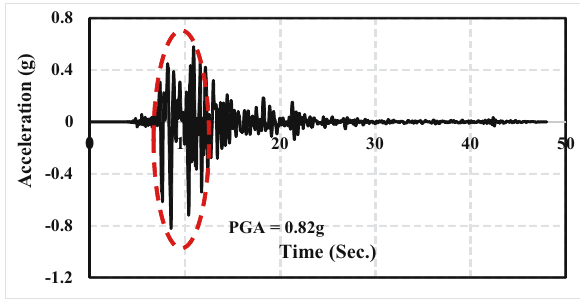
Figure 2: Seismogram of Kobe earthquake history used in the pre - sent study [ 8 ] .